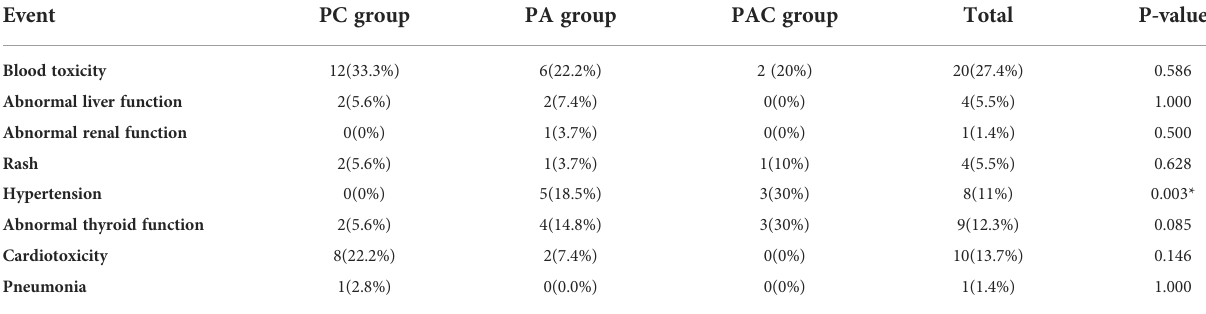
TABLE 7 Incidence of adverse events